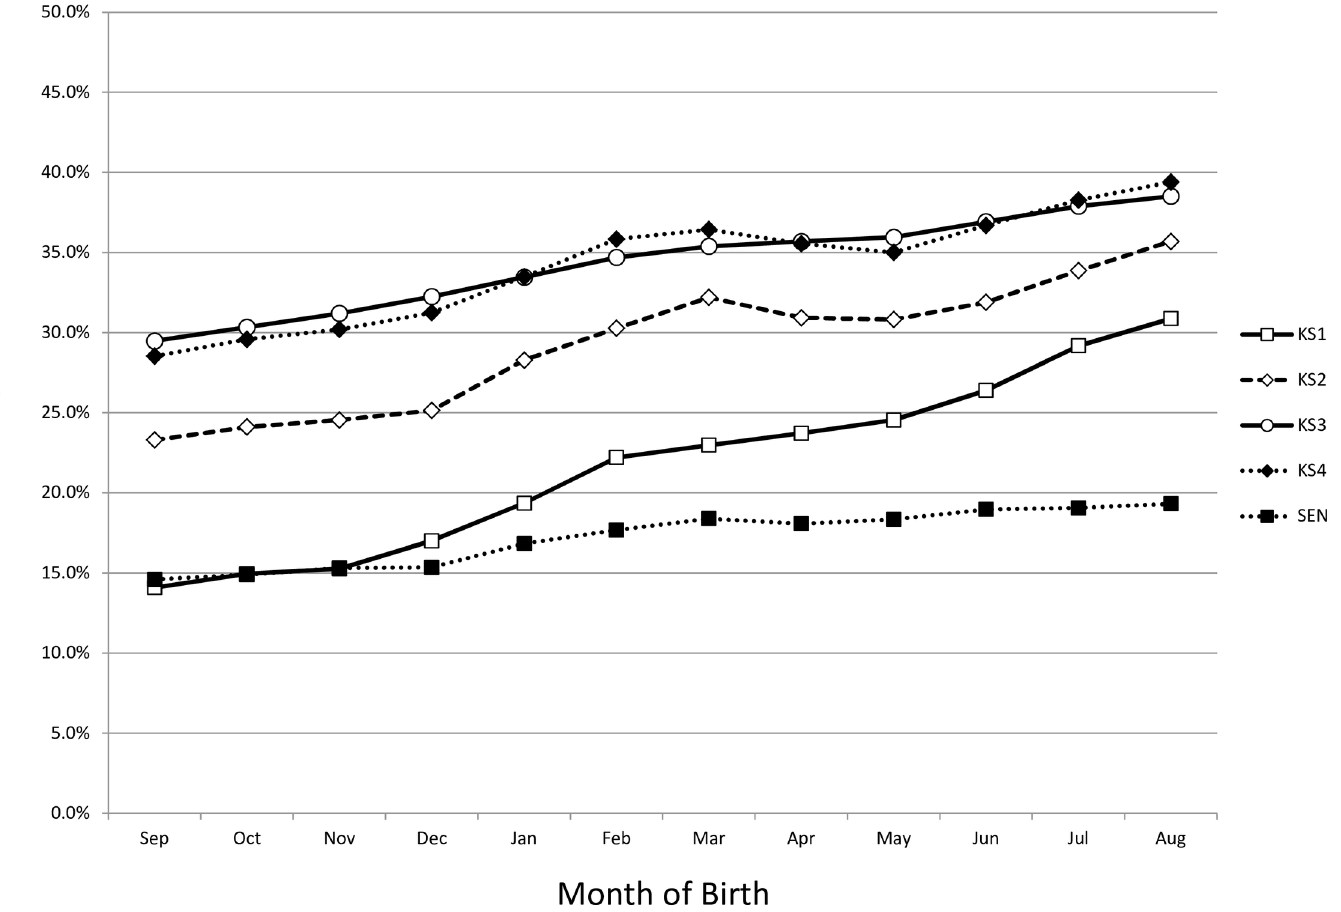
Fig 1. Proportion of children failing Key Stages 1 – 4 and requiring SEN in KS4, by month of birth. (N.B. School entry based on age on the 1 st of September)